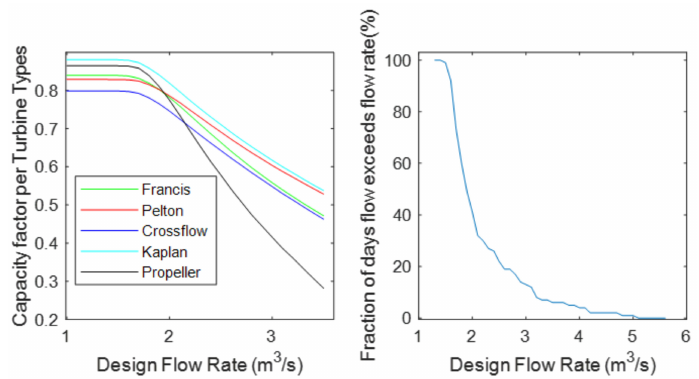
Figure 7. Capacity factor as a function of the river flow rate. Left panel: plant capacity factor for several common turbine types, as a function of the designed flow rate of the hydropower plant. Right panel: River flow exceedance